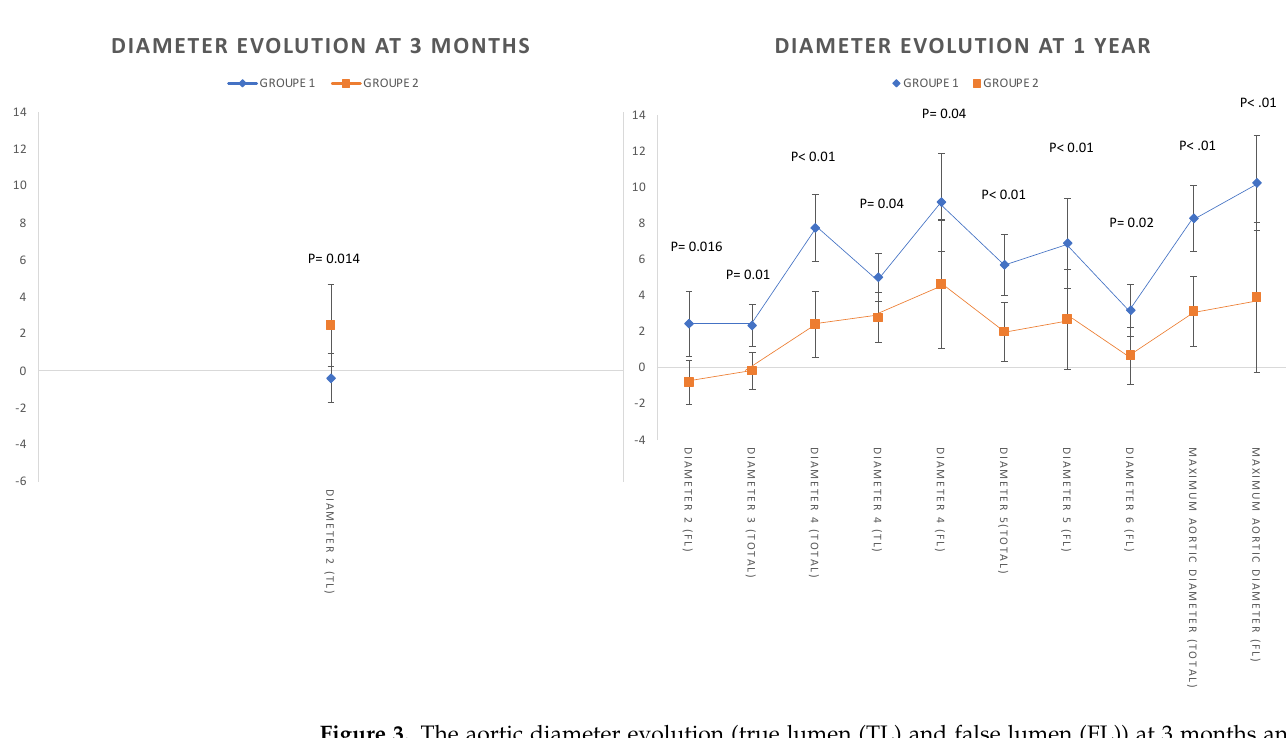
Figure 3. The aortic diameter evolution (true lumen (TL) and false lumen (FL)) at 3 months and 1 year: significant evolution in the aortic diameter within the different diameters.